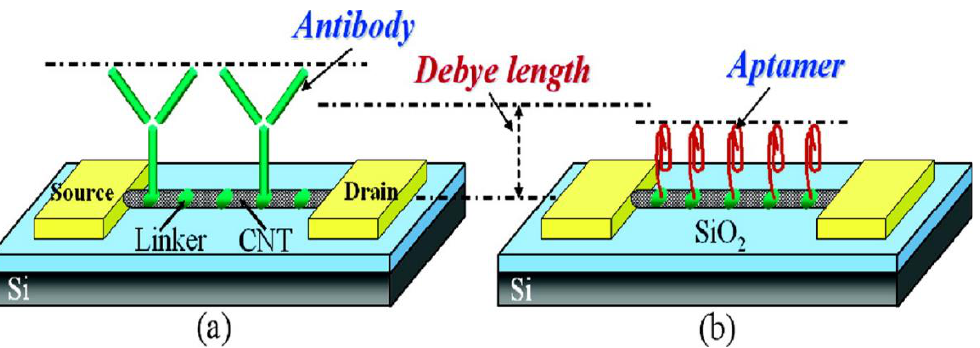
Figure 7. A label-free protein biosensor based on a CNT-FET: ( a ) antibody-modified CNT-FET; ( b ) Aptamer-modified CNT – FET. Reproduced from Kenzo et al. [134] by permission of the American Chemical Society.